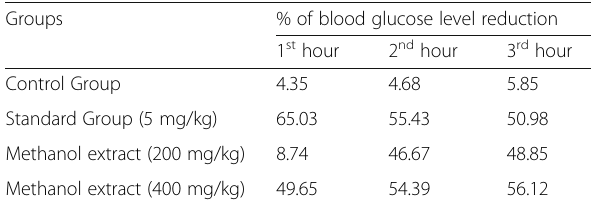
Table 8 Percentage of blood glucose level reduction in Swiss albino mice Groups